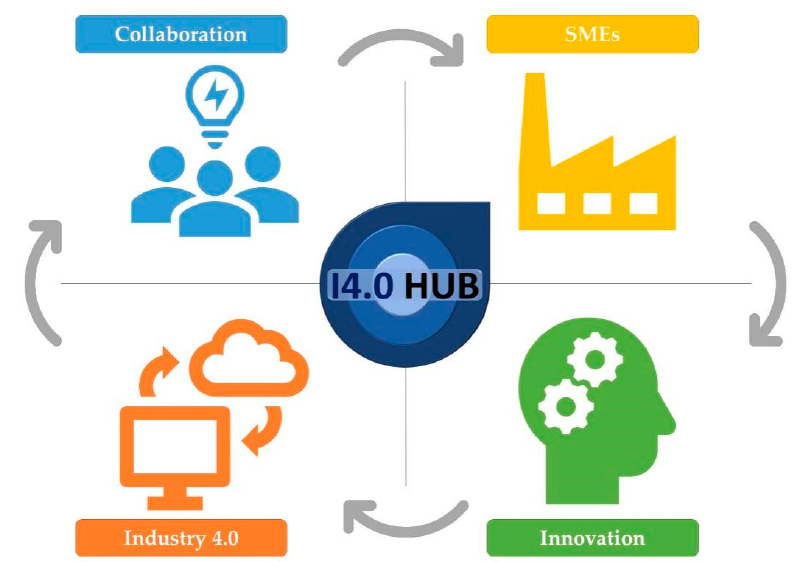
Figure 5. Industry 4.0 knowledge transfer for SMEs.